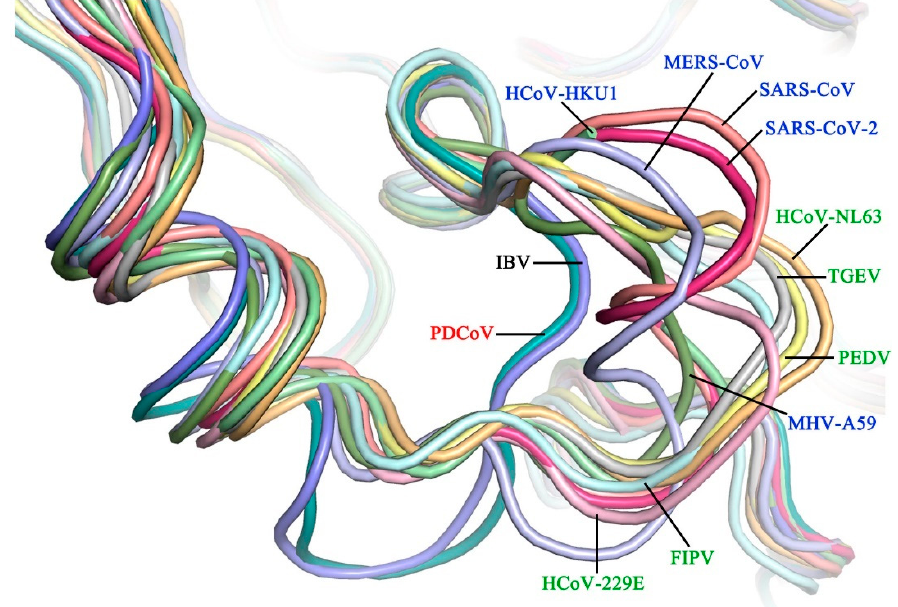
Figure 5. Structures of the backbone of a loop containing residues 41–51 in M pro s from four different genera (PDCoV, deep teal; HCoV-NL63, light orange; HCoV-229E, light pink; FIPV, pale cyan; PEDV, pale yellow; TGEV, silver; SARS-CoV-2, warm pink; SARS-CoV, salmon; MERS-CoV, light blue; HCoV-HKU1, pale green; MHV-A59, sumudge; IBV, slate). The peptidomimetic inhibitor N3, which carries a Michael acceptor warhead, was also effective against M pro of PDCoV, the newly emerging Deltacoronavirus .